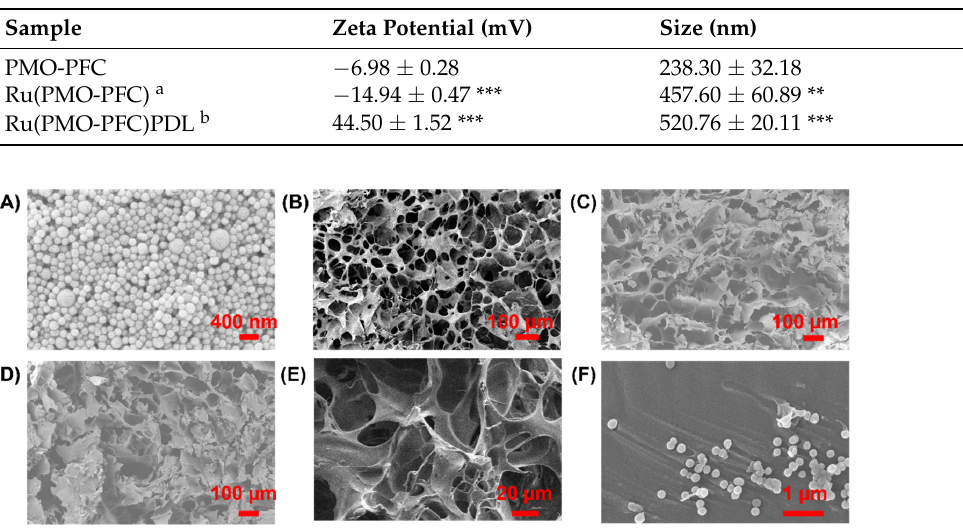
Method section. The scaffolds with PMO ‐ PFC, Ru(PMO ‐ PFC) and Ru(PMO ‐ PFC)PDL are denoted as G+PMO ‐ PFC, G+Ru(PMO ‐ PFC), G+Ru(PMO ‐ PFC)PDL, respectively. The hy ‐ drogels were also characterized for morphological properties by SEM (Figure 1B–E). The SEM images show the porous structure of the prepared scaffolds. The average size of the PMO ‐ PFCs is 143 ± 12 nm (Figure 1A). The zoom ‐ in image (Figure 1F) shows the distribu ‐ tion of PMO ‐ PFCs within hydrogel network. The aggregation of PMO ‐ PFCs is expected, due to the hydrophobic nature of the particles. Rheologic properties such as viscosity ( ⴄ ), storage (G’) and loss modulus (G”), are important factors to determine the injectability of the hydrogel. The ability of hydrogels to change viscosity in response to the changes in shear stress is crucial for injectable hy ‐ drogels. Hydrogels with a lower viscosity and lower storage and loss moduli are typically easier to inject than hydrogels with a high viscosity and high storage and loss moduli. The viscosity of the G+PMO ‐ PFC, G+Ru(PMO ‐ PFC) and G+Ru(PMO ‐ PFC)PDL hydrogels de ‐ creases with increasing shear rate and demonstrates the shear thinning property (Figure 2A). Storage and loss moduli are the elastic and viscous responses of a hydrogel to oscil ‐ latory shear. A higher storage modulus than loss modulus for the G+PMO ‐ PFC, G+Ru(PMO ‐ PFC) and G+Ru(PMO ‐ PFC)PDL hydrogels over the entire range of angular velocities demonstrates their viscoelastic properties (Figure 2B). The shear thinning and viscoelastic properties of prepared NC hydrogels show their ability for use as injectable hydrogels and as hydrogel precursors for printing 3D scaffolds. For the compression test, the cylindrical scaffolds were prepared according to the earlier ‐ mentioned method. The NC ‐ hydrogel scaffolds show a higher compression modulus than the GelMa ‐ based scaf ‐ fold at 100 N (Figure 2C), indicating stronger mechanical compressive properties of NC hydroge,l due to incorporation of NPs. This is due to the non ‐ covalent interactions be ‐ tween the polymer networks of hydrogel ‐ and O 2 ‐ carrying NPs. The G+Ru(PMO ‐ PFC) shows a higher compression modulus than the GelMa ‐ based scaffold and G+PMO ‐ PFC, perhaps because of the interaction of GelMa with the hydroxyl ‐ groups of the rutin. G+Ru(PMO ‐ PFC)PDL shows more stiffness (highest compression modulus among others) due to the distribution of hydrophilic PDL ‐ coated particles within the hydrogel network. The swelling and degradation of the scaffold were also measured (Figures S2 and S3). The G+PMO ‐ PFC, G+Ru(PMO ‐ PFC), and G+Ru(PMO ‐ PFC)PDL scaffolds exhibited a low swelling ratio and less degradation compared with the GelMa ‐ based scaffold (see Supple ‐ mentary Information). To summarize, the prepared NC ‐ hydrogel scaffolds show better